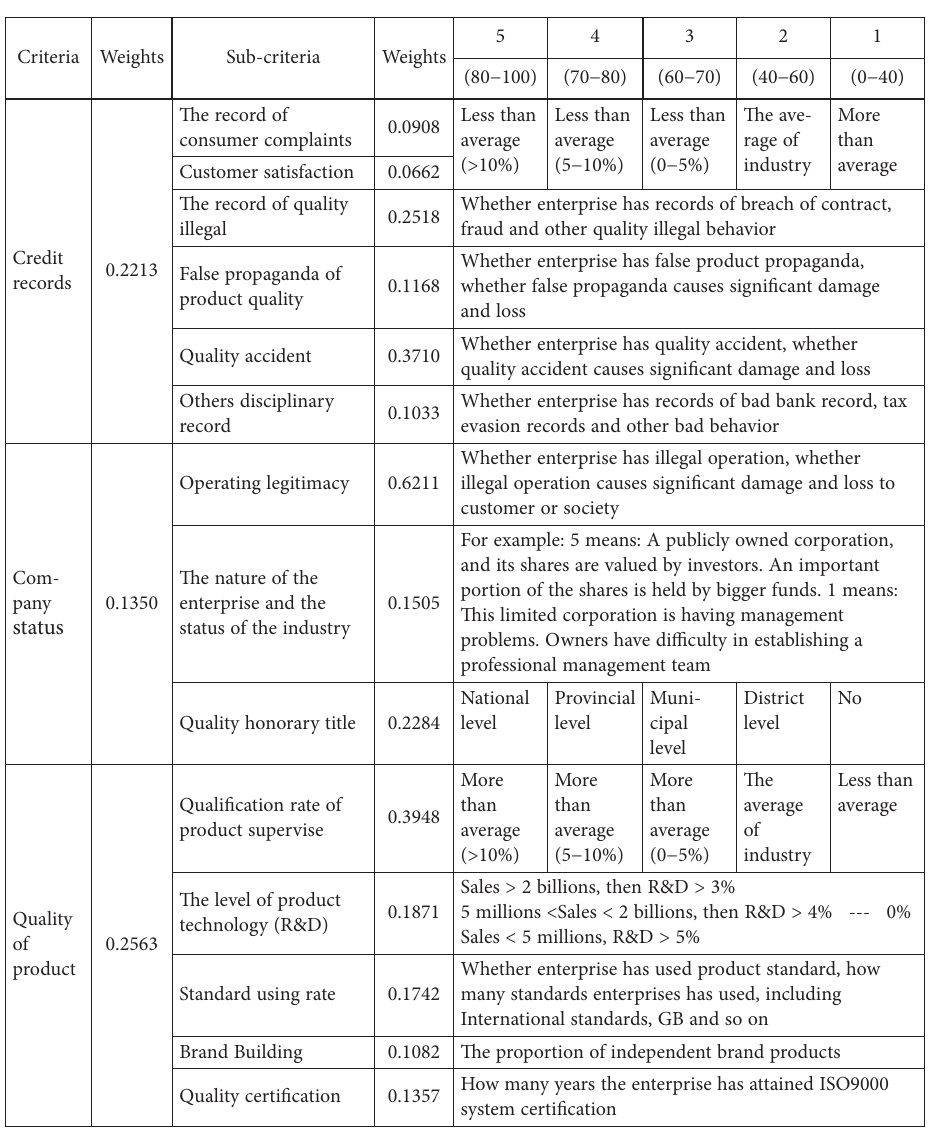
Table 18. Scorecards for Sub-criteria